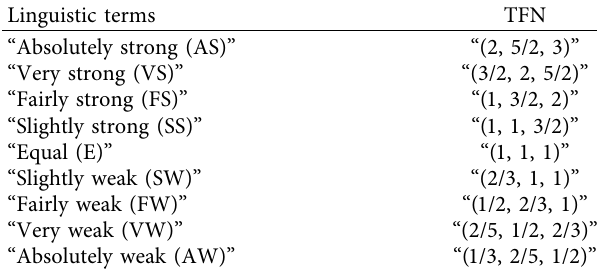
Table 1: Scale for criteria evaluation in HF-AHP.